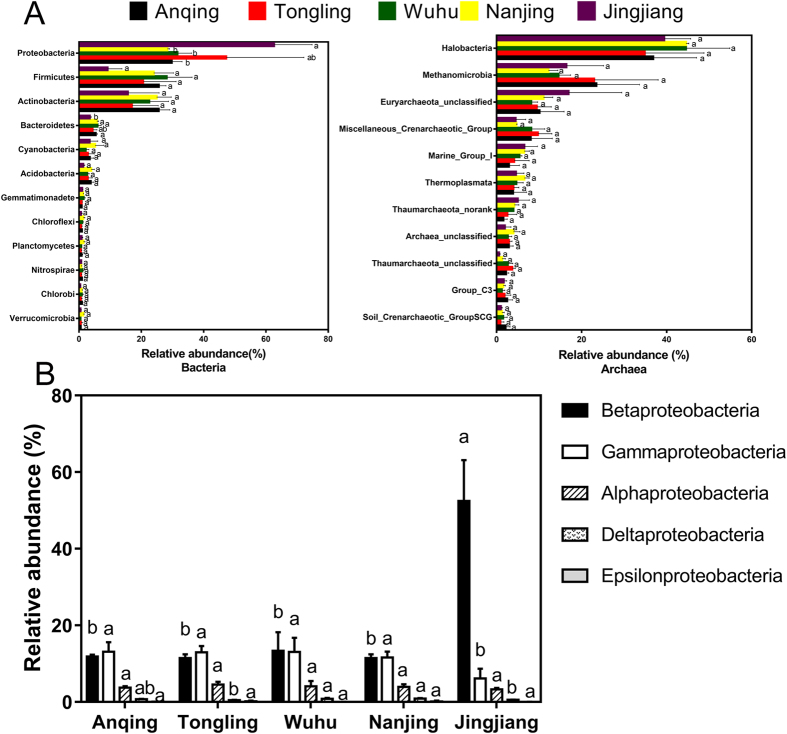
Comparison of the taxonomic composition in all water samples along the lower reaches of Yangze River.The relative abundances (percentage) at phylum (bacteria) and class levels (archaea) that were more than 1% were listed in panel A. The relative abundances of the five classes within the Proteobacteria phylum were listed in panel B. The legends with different colors in panel A represented the five sampling sites, while the different filling patterns of them in panel B represented different classes within the Proteobacteria phylum. The letters upon at the right side of the columns show the differences between groups. The same letters mean no significant differences, while different letters mean that there are statistically significant differences between groups at 95% level.